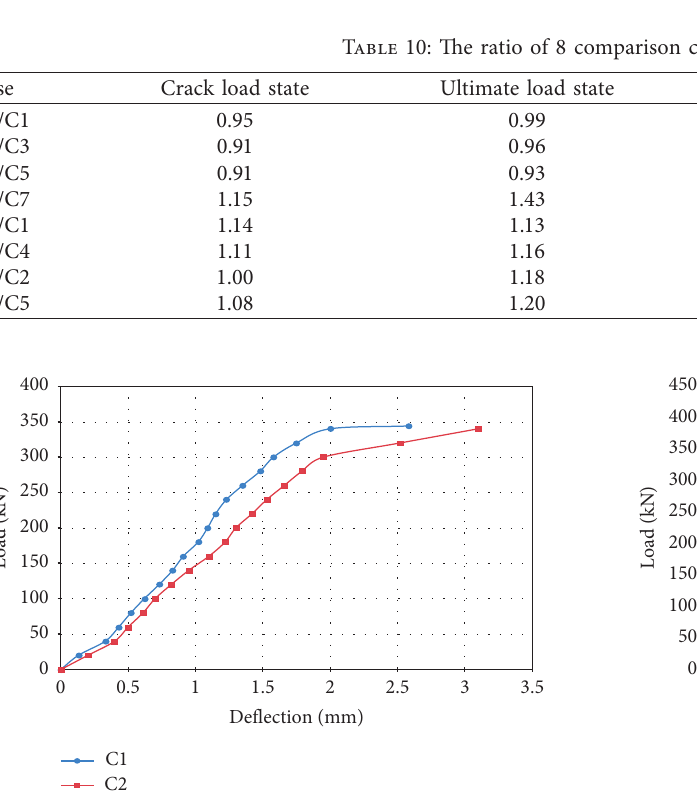
Figure 5: Load-deflection relationship of corbels with 0% and 100% weight fractions of replacement aggregate for concrete strength 28.2 and 28.0MPa and a/d ratio 0.5.